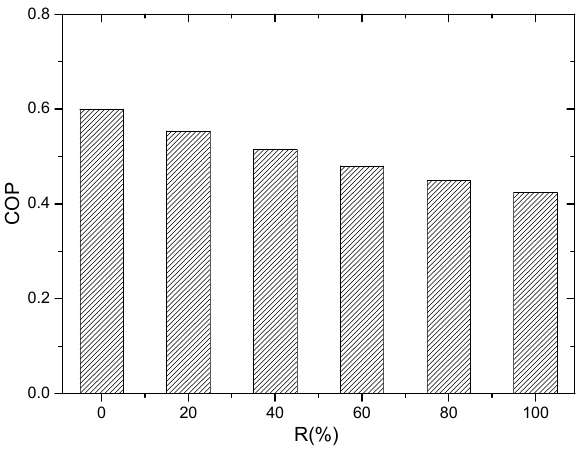
Figure 14. COP with different mass ratio.